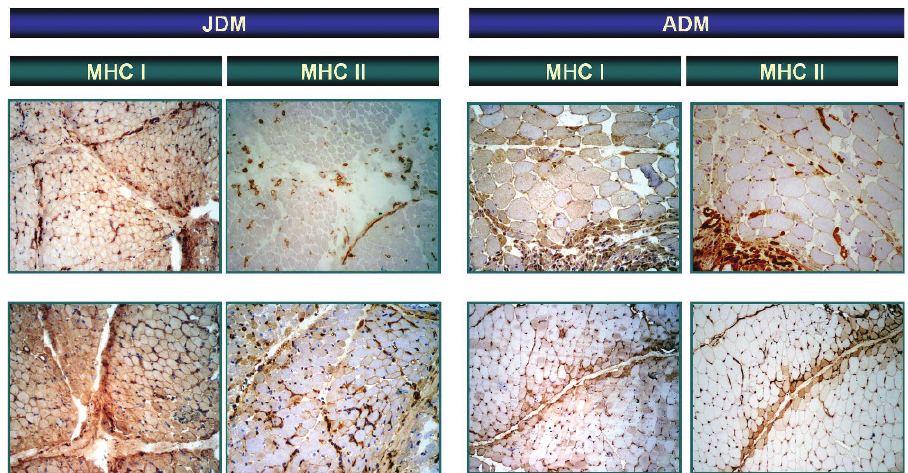
Figure 1 - Major histocompatibility complex I and II expression in muscle fibre membrane surface of juvenile and adult dermatomyositis. Notes: The immunohistochemistry analysis demonstrates significantly higher major histocompatibility complex I expression in fibres of juvenile dermatomyositis compared to adult dermatomyositis, in contrast to major histocompatibility complex